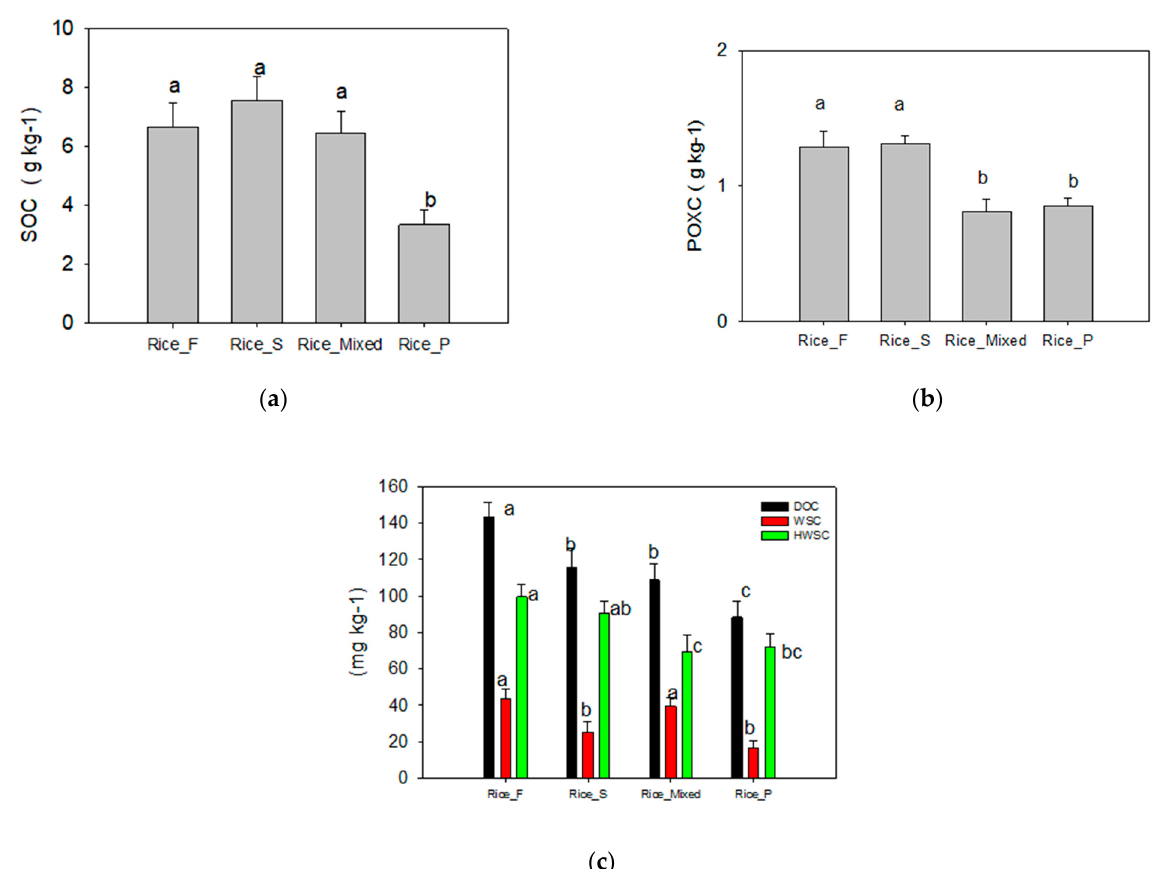
Figure 3. The influence of the RRCSs on the contents of SOC ( a ); POXC ( b ); and labile carbon fraction in terms of DOC, HWSC, and WSC ( c ). Note: The bars with the standard error of the mean and labeled with different lowercase letters indicate a difference between rice rotation patterns ( p < 0.05).